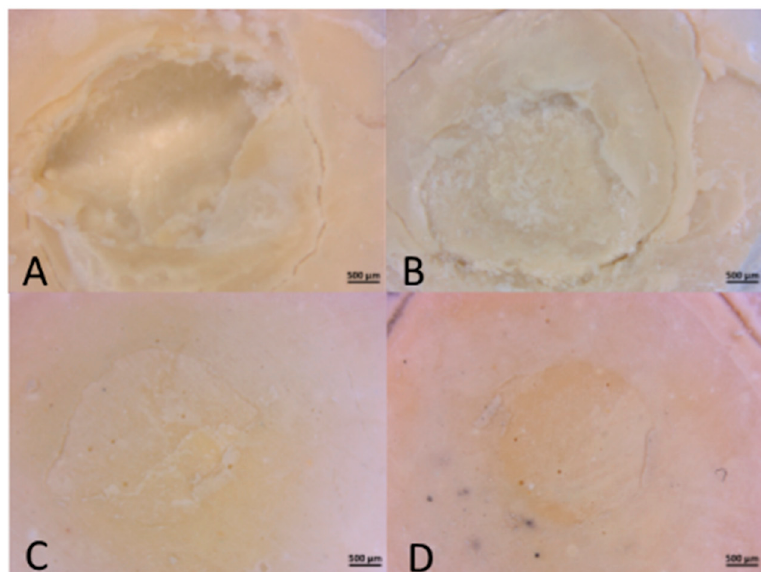
Figure 2. Stereomicroscopic images of the failure mode in different experimental groups under 0.945× magnification (scale bar = 500 µ m). ( A ) Cohesive failure at 12 min in Biodentine self-etch; ( B ) cohesive failure at 12 min in Biodentine total etch (two steps); ( C ) adhesive failure at 24 h in Biodentine self-etch; ( D ) adhesive failure at 24 h in Biodentine total etch (two steps).